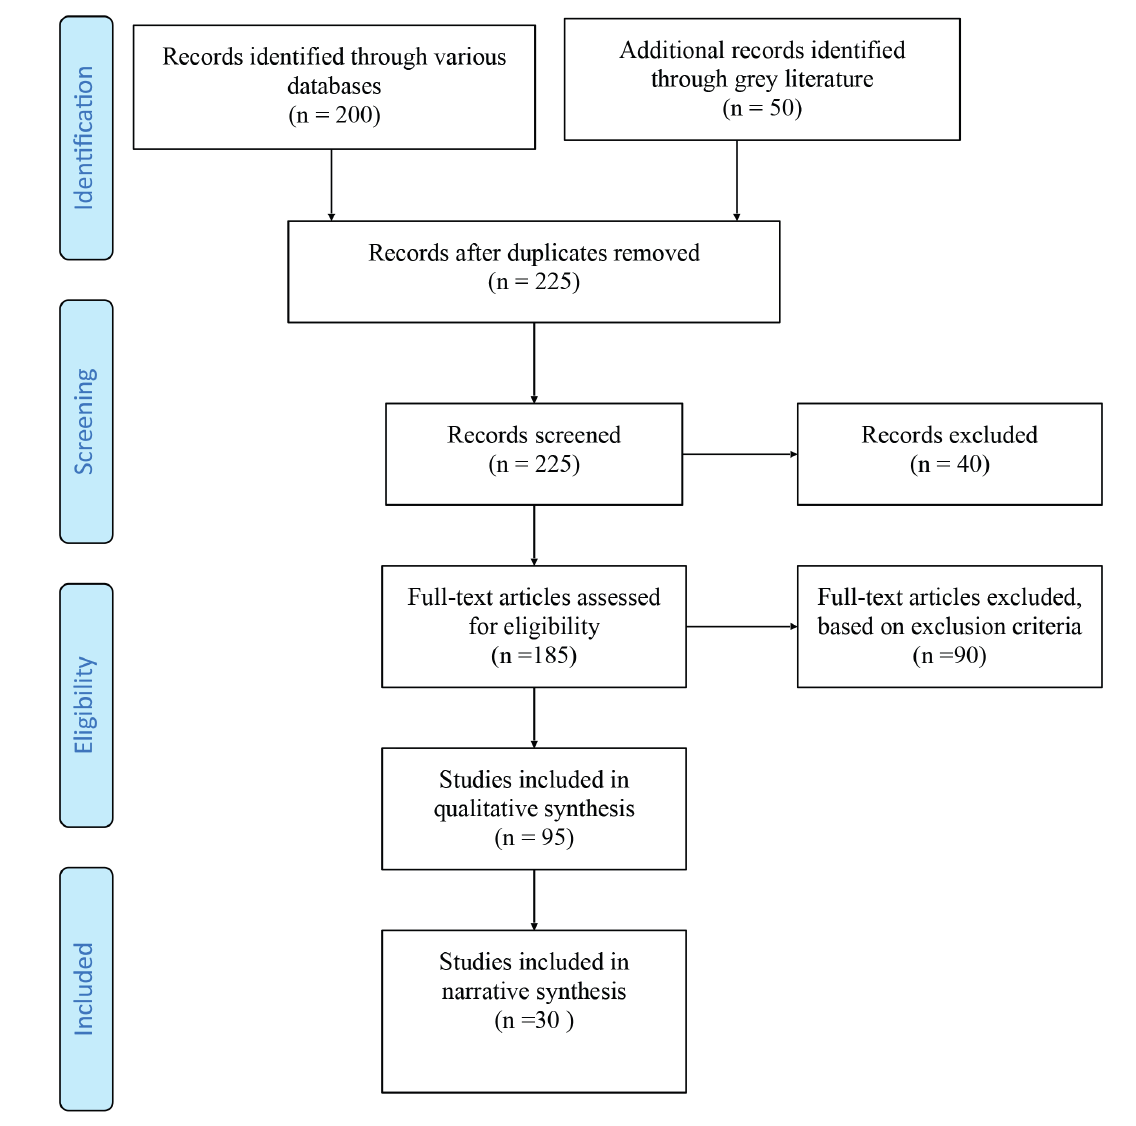
Figure 1. PRISMA Flowchart of the review